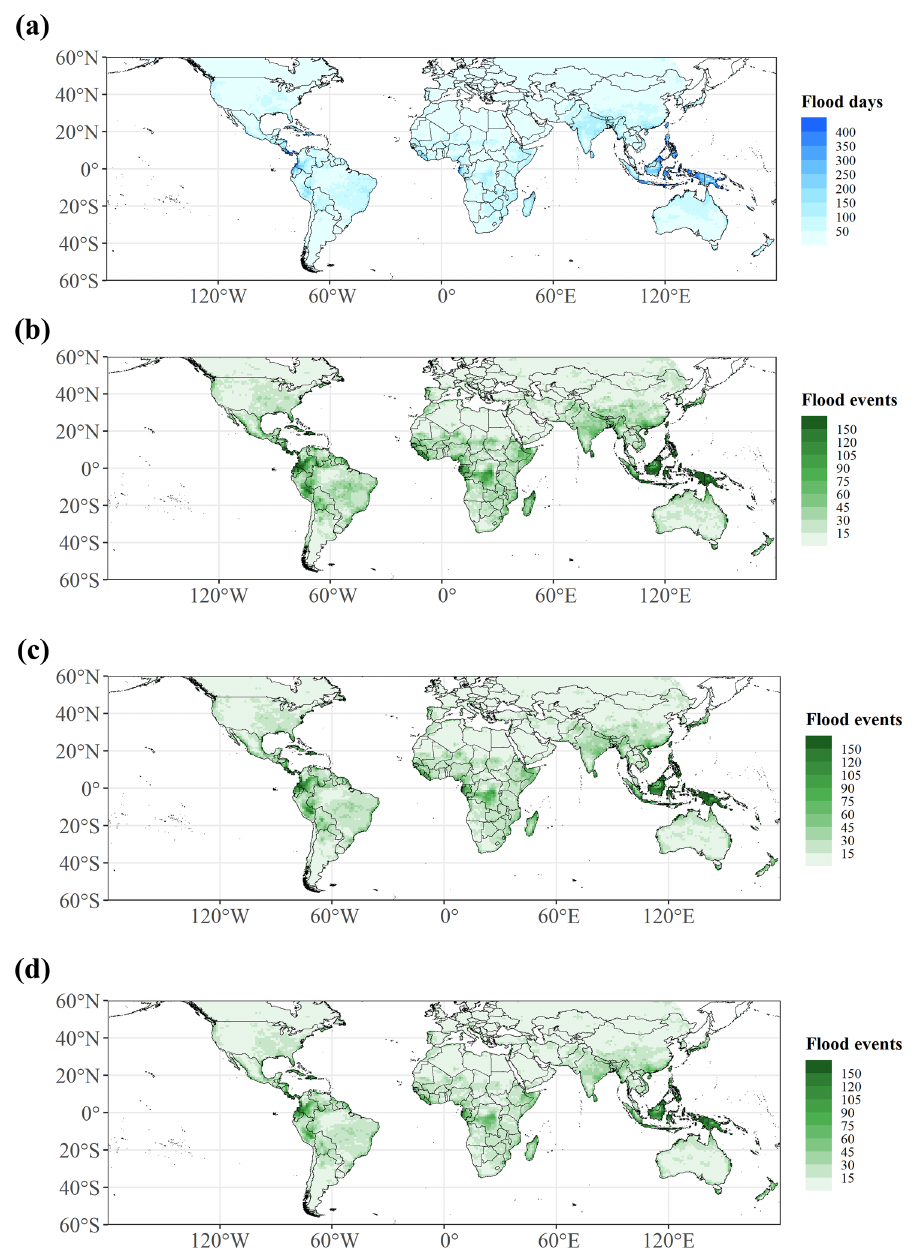
Figure 2. Spatial distribution of global floods: (a) global flood days from 1 April 2002 to 31 August 2016; (b) global flood events based on consecutive flood days; (c) global flood events based on the interval between 2 consecutive flood days not exceeding 3d; (d) global flood events based on the interval between 2 consecutive flood days not exceeding